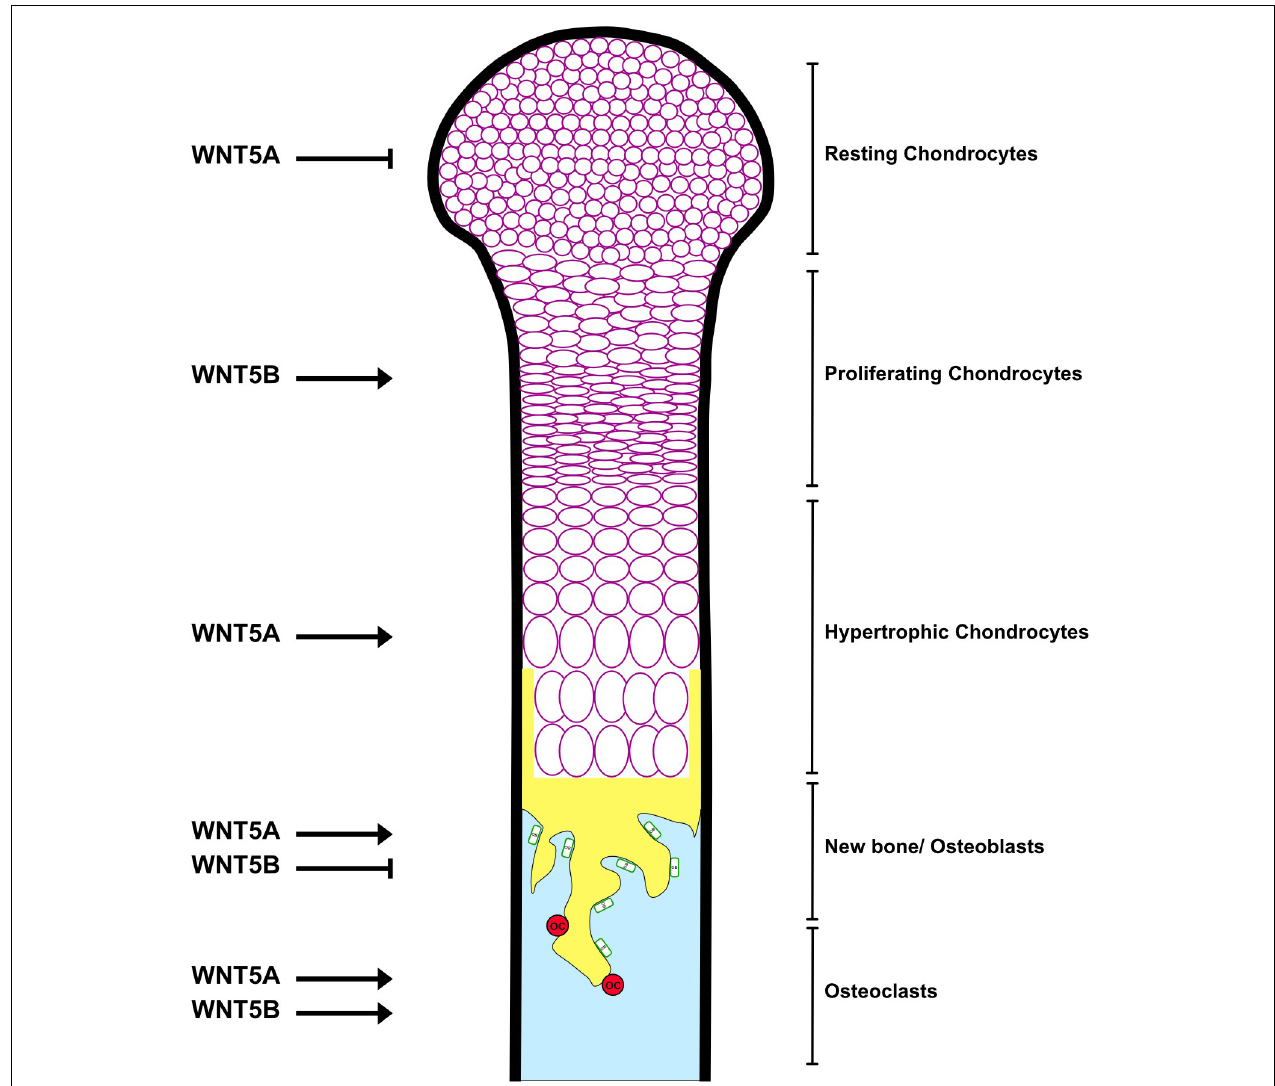
FIGURE 2 | The roles of WNT5A and WNT5B in the bone. See the text for